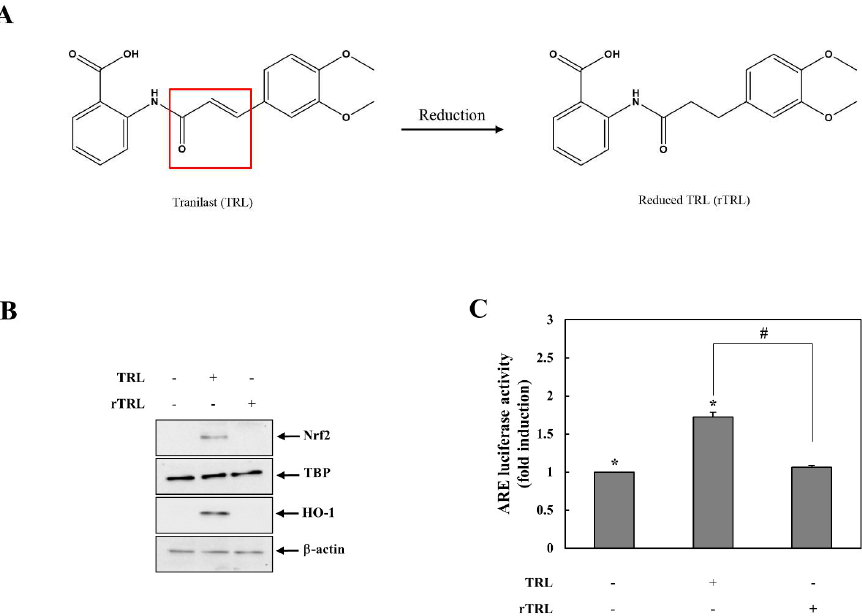
Figure 2. Reduced TRL is unable to activate Nrf2. ( A ) TRL was reduced to remove the electrophilic functional group in it. The box indicates the elctrophilic fuctional group. ( B ) HCT116 cells were treated with 200 µ M of either TRL or rTRL. Nuclear Nrf2 and HO-1 protein levels were assessed after 2 and 8 h, respectively, by western blotting. ( C ) HCT116 cells were cotransfected with an ARE-responsive luciferase reporter plasmid and a CMV Renilla luciferase plasmid for 24 h. The cells were treated with 200 µ M of either TRL or rTRL for 8 h. Luciferase activity was measured and normalized to CMV Renilla luciferase activity. For western blotting in ( B ), equivalent loading of proteins was verified using TATA box protein (TBP) for nuclear Nrf2 protein and β -actin for HO-1 protein. NM, not measurable. Data in ( C ) are presented as mean ± standard deviation ( n = 3). *: p < 0.05 vs. control, #: p <